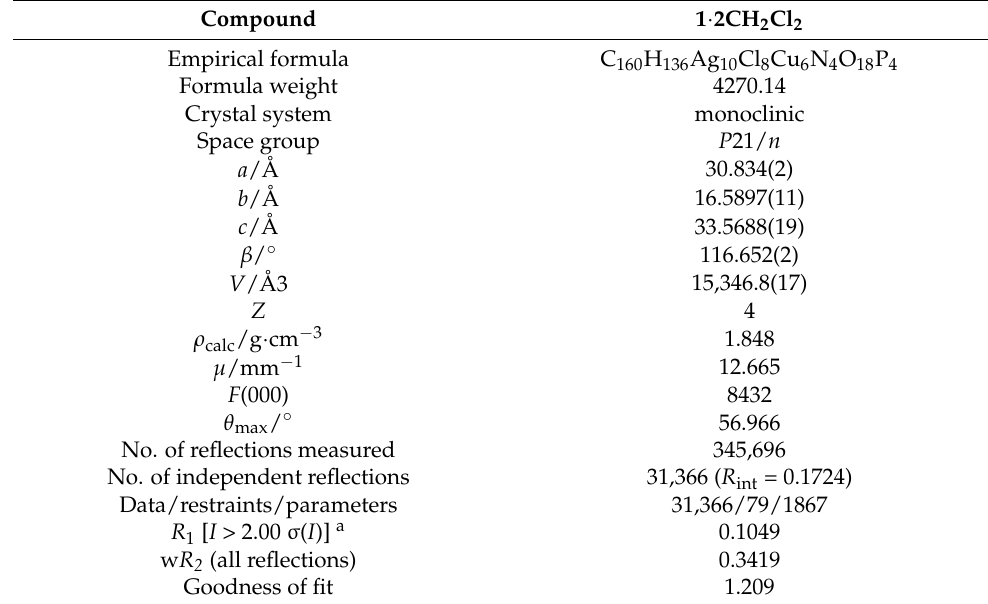
Table 1. Selected crystallographic data and refinement parameters for 1 · 2CH 2 Cl 2